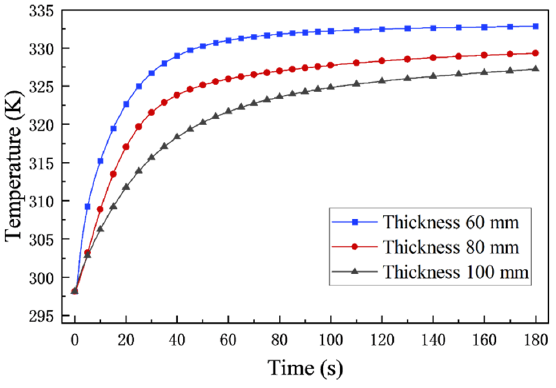
Figure 10. Overall average temperature of the heaped tobacco strips models.